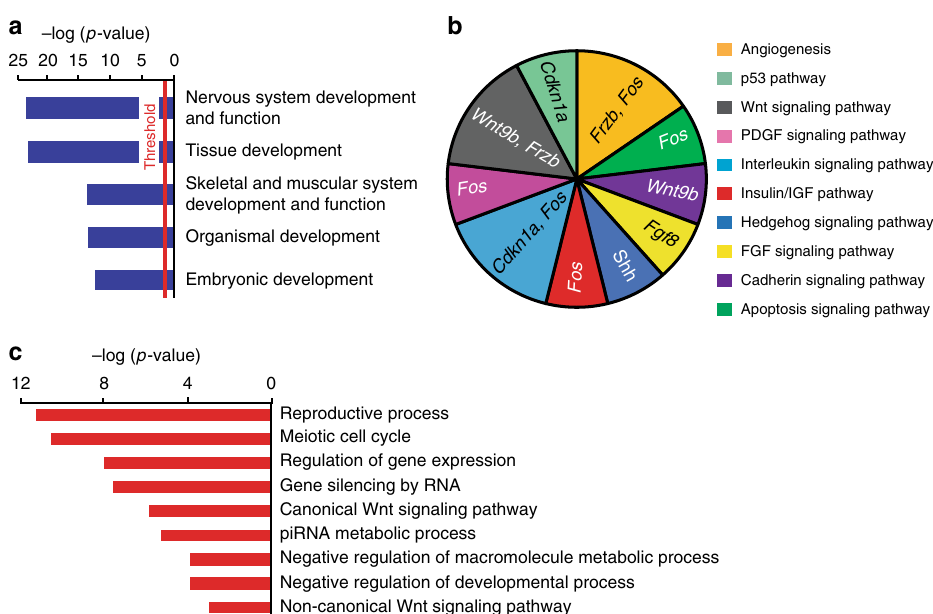
Fig. 6 Dnmt3b controls developmental pathways involved in embryogenesis. a Ingenuity pathway analysis (IPA) of genes differentially expressed (FC ≥ 2, p < 0.05) in E11.5 Dnmt3b − / − embryo. The top subcategories obtained in a category Physiological system development and function are displayed ( p < 0.05 by right-tailed Fisher ’ s exact test). b Panther pathway analysis of upregulated genes (FC ≥ 2, p < 0.05 by DESeq) identi fi ed in E11.5 Dnmt3b − / − embryo, which were found to be enriched in IPA analysis in a subcategory Embryonic development. c Gene ontology analysis of up-regulated genes (FC ≥ 2, p < 0.05 by DESeq) identi fi ed in E11.5 Dnmt3b − / − embryo, which were found to be enriched in IPA analysis in a subcategory Embryonic development.